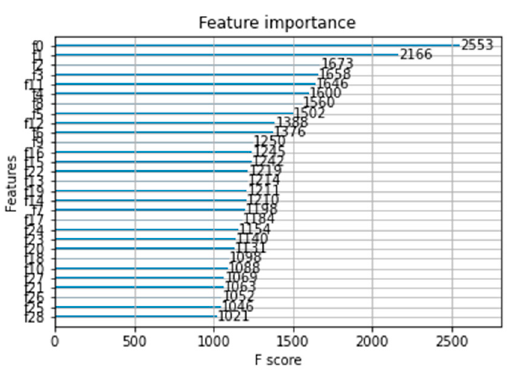
Figure 9. The Selection results of the feature bands of the KPCA-LDA-XGB model.